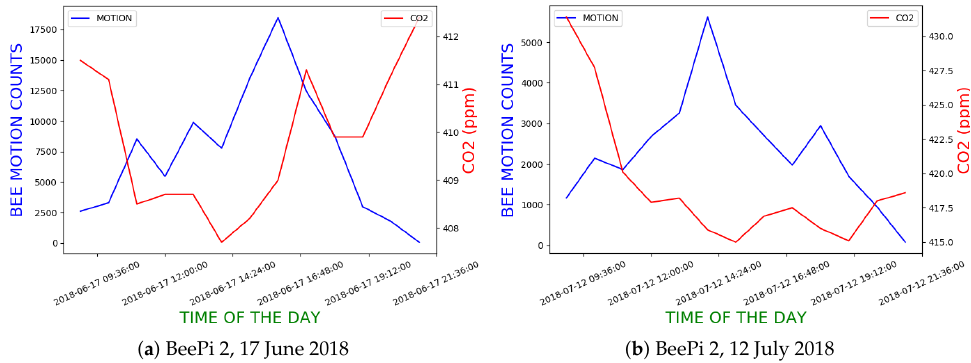
Figure 11. Alignment of CO 2 measurements from USU UCC weather station with BeePIV motion counts from videos from BeePi monitor 2 in Logan, UT.